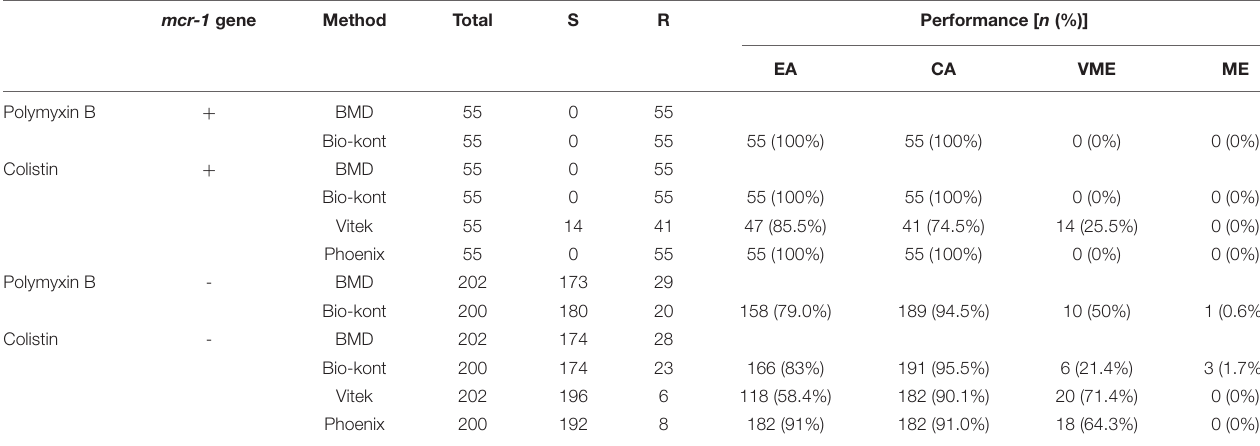
TABLE 3 | Comparison of performance characteristics to colistin and polymyxin B between each of the three AST systems and BMD method for strains of different mcr-1 genetic conditions. mcr-1